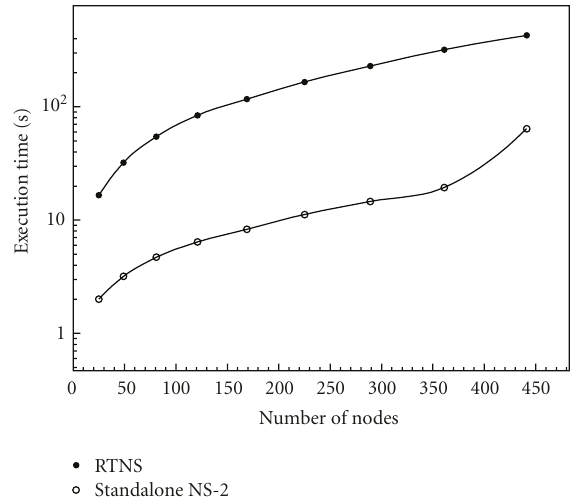
Figure 14: RAM maximum usage of NS-2 and RTNS as a function of the total number of nodes.